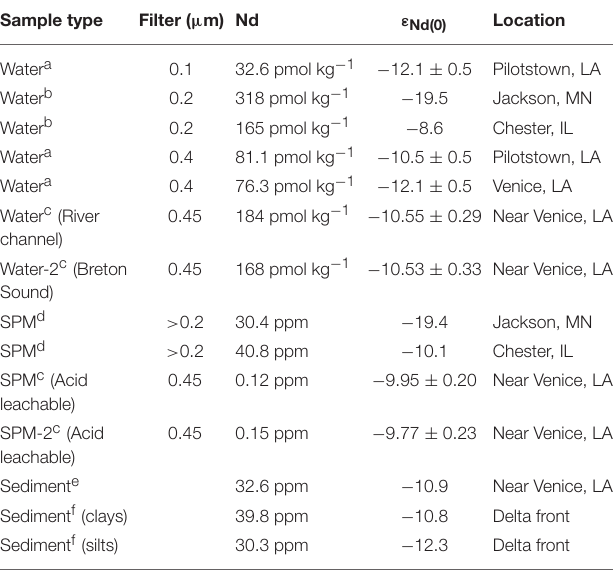
TABLE 5 | Neodymium concentrations and isotopic compositions, ε Nd(0) values, of Mississippi River water, suspended particulate matter (SPM), and sediment. Sample